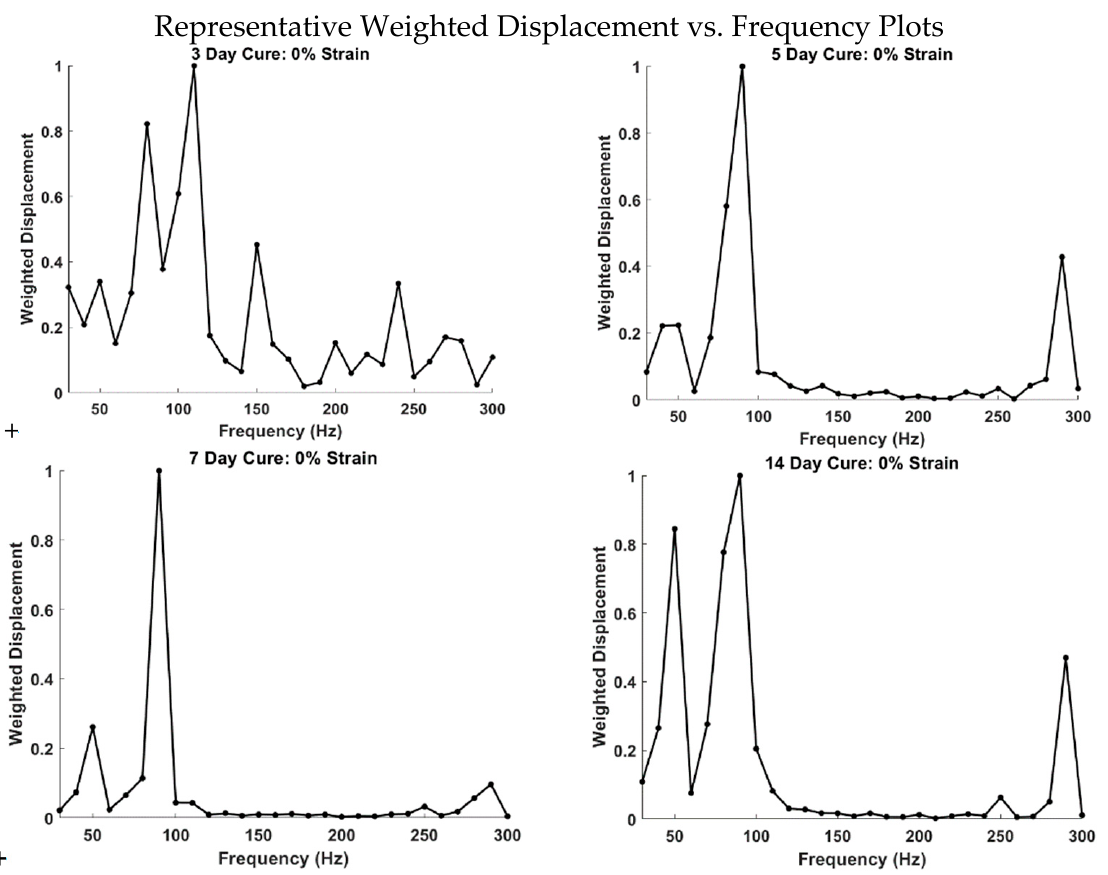
Figure 1. Typical normalized weighted displacement versus frequency (in Hz) plots for silicone sealant specimens at 0% strain determined in vitro using VOCT. Note the presence of extra peaks relative to the resonant frequency peak (80 ± 10 Hz) in the specimens cured for 3 and 14 days and the lack thereof in the specimens cured for 5 and 7 days. The weighted displacement of each sample was normalized by dividing by the displacement of the speaker in the absence of the sample as well as by the largest peak in the spectrum.